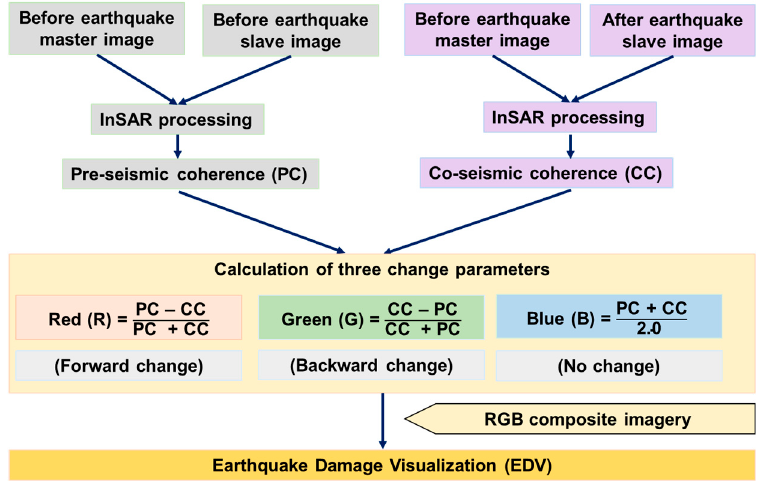
Figure 2. Flow chart showing creation of the Earthquake Damage Visualization (EDV).